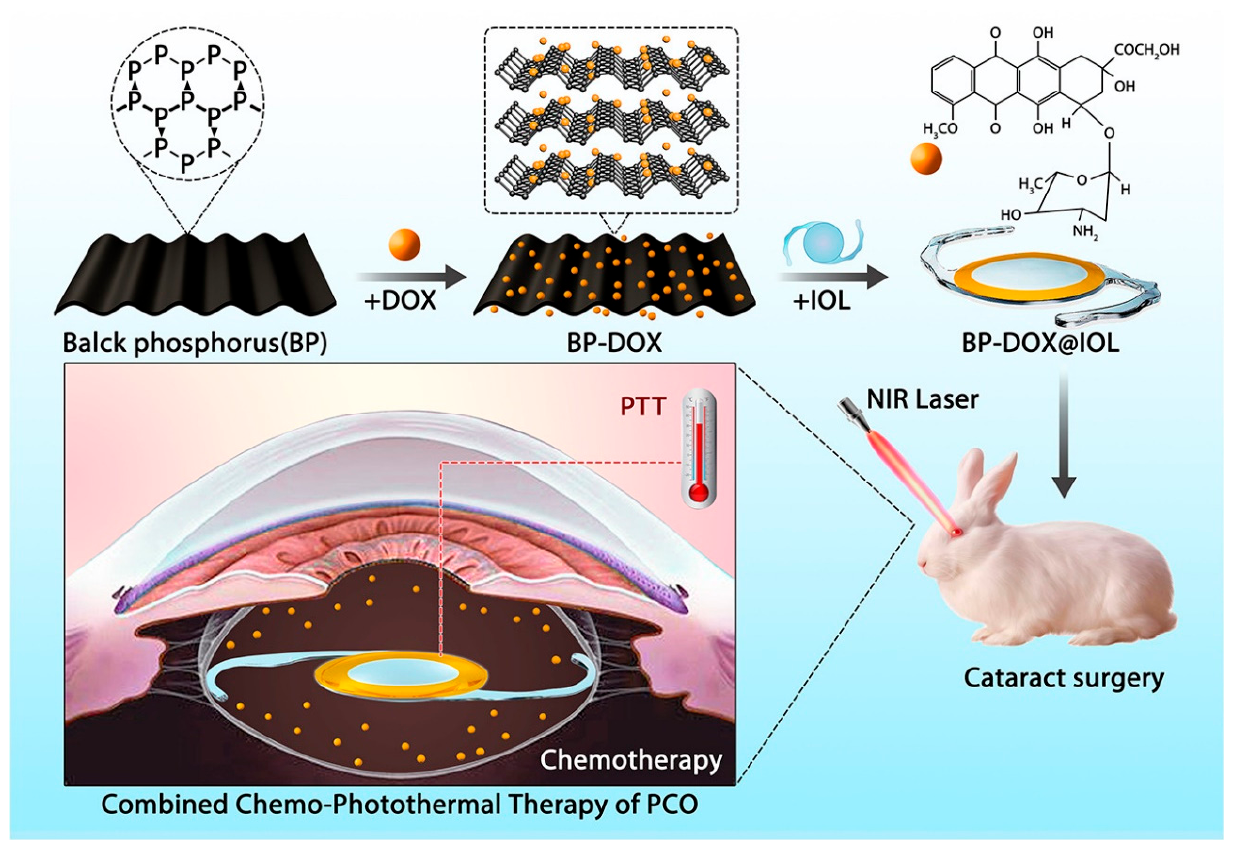
Figure 6. The schematic illustration of BP-based drug delivery system for synergistic chemo-photothermal therapy of PCO. Adapted with permission from Ref. [85]. Copyright 2021 Elsevier. Table 2. Summary of reviewed literature of photothermal and photodynamic IOLs for PCO prophy- laxis with in vivo results.